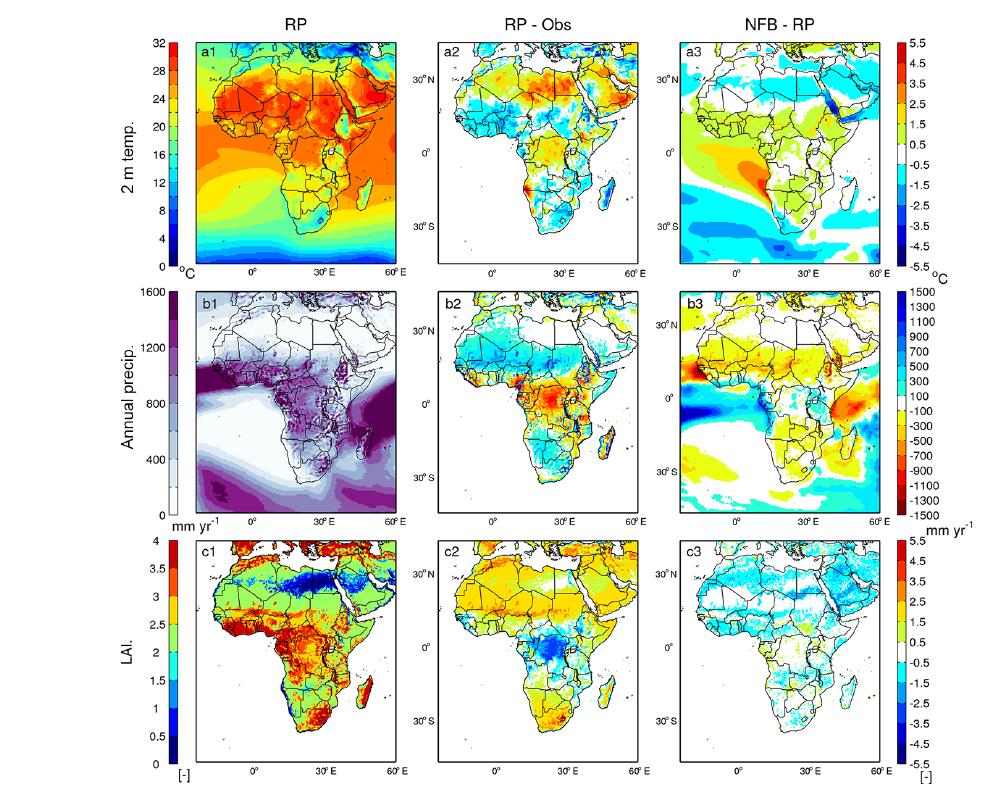
Figure 1. Comparison between simulated and observed (a) annual mean near-surface air temperature, (b) annual precipitation and (c) annual maximum LAI for the period 1997–2010. Variables from the RP experiment (a1–c1) are compared with observations (a2–c2) and with those from the FB experiment (a3–c3) , using RP minus observation and FB minus RP. For the comparison with observations (a2–c2) , we used CRU temperature (a2) and precipitation (b2) , as well as LAI3g (Zhu et al., 2013) (c2)